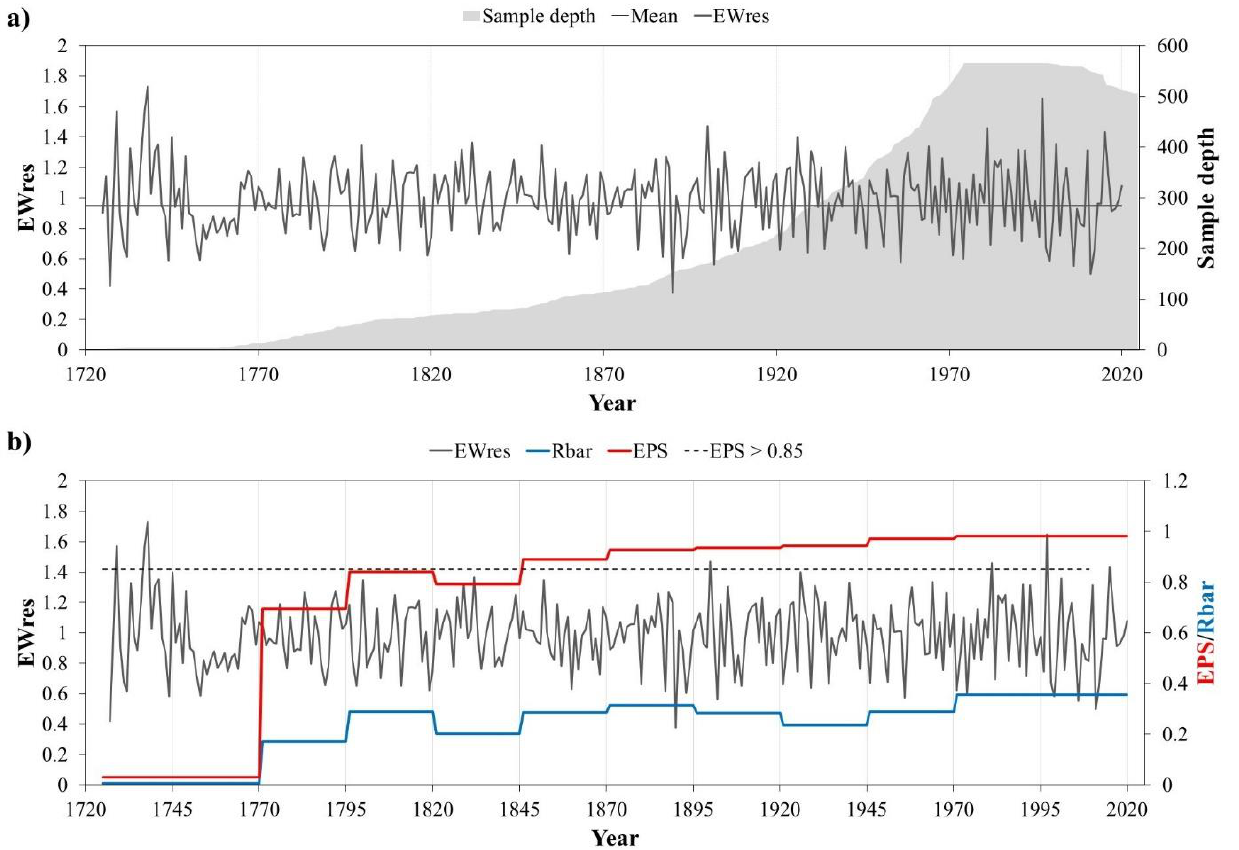
Figure 2. ( a ) Earlywood residual chronology (EWres) of Pinus durangensis (gray line). The black horizontal line represents the average index value that shows the interannual variability for the period 1725 – 2020; the gray shaded area represents the number of radii used to produce each annual index value (right y-axis). ( b ) Earlywood residual chronology (EWres) of Pinus durangensis (gray line). The running EPS was calculated based on the number of sampled trees and is represented by a red line and the minimum EPS of 0.85 is represented by the black horizontal dotted line. The running Rbar is represented in a blue line.